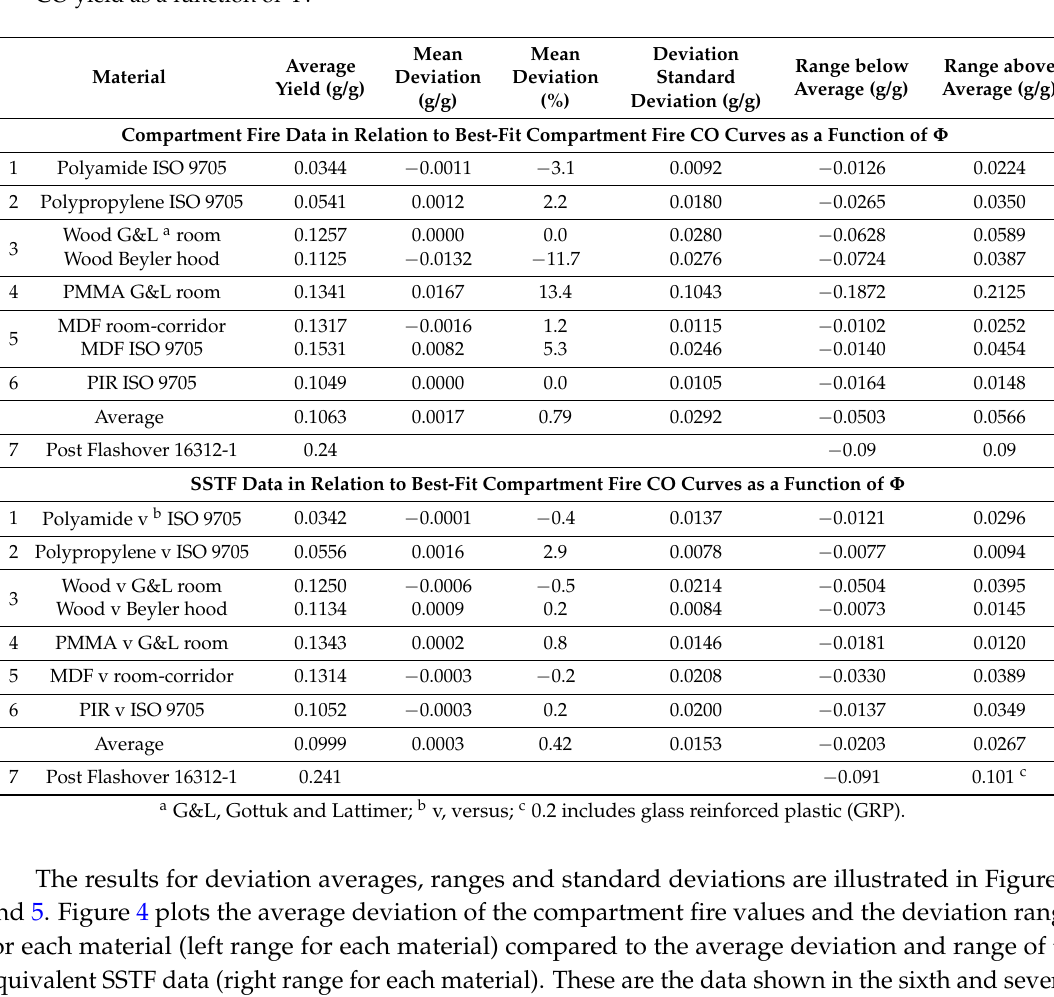
Table 5. Accuracy and uncertainty of compartment fire and SSTF data in relation to best-fit curves for CO yield as a function of Φ .